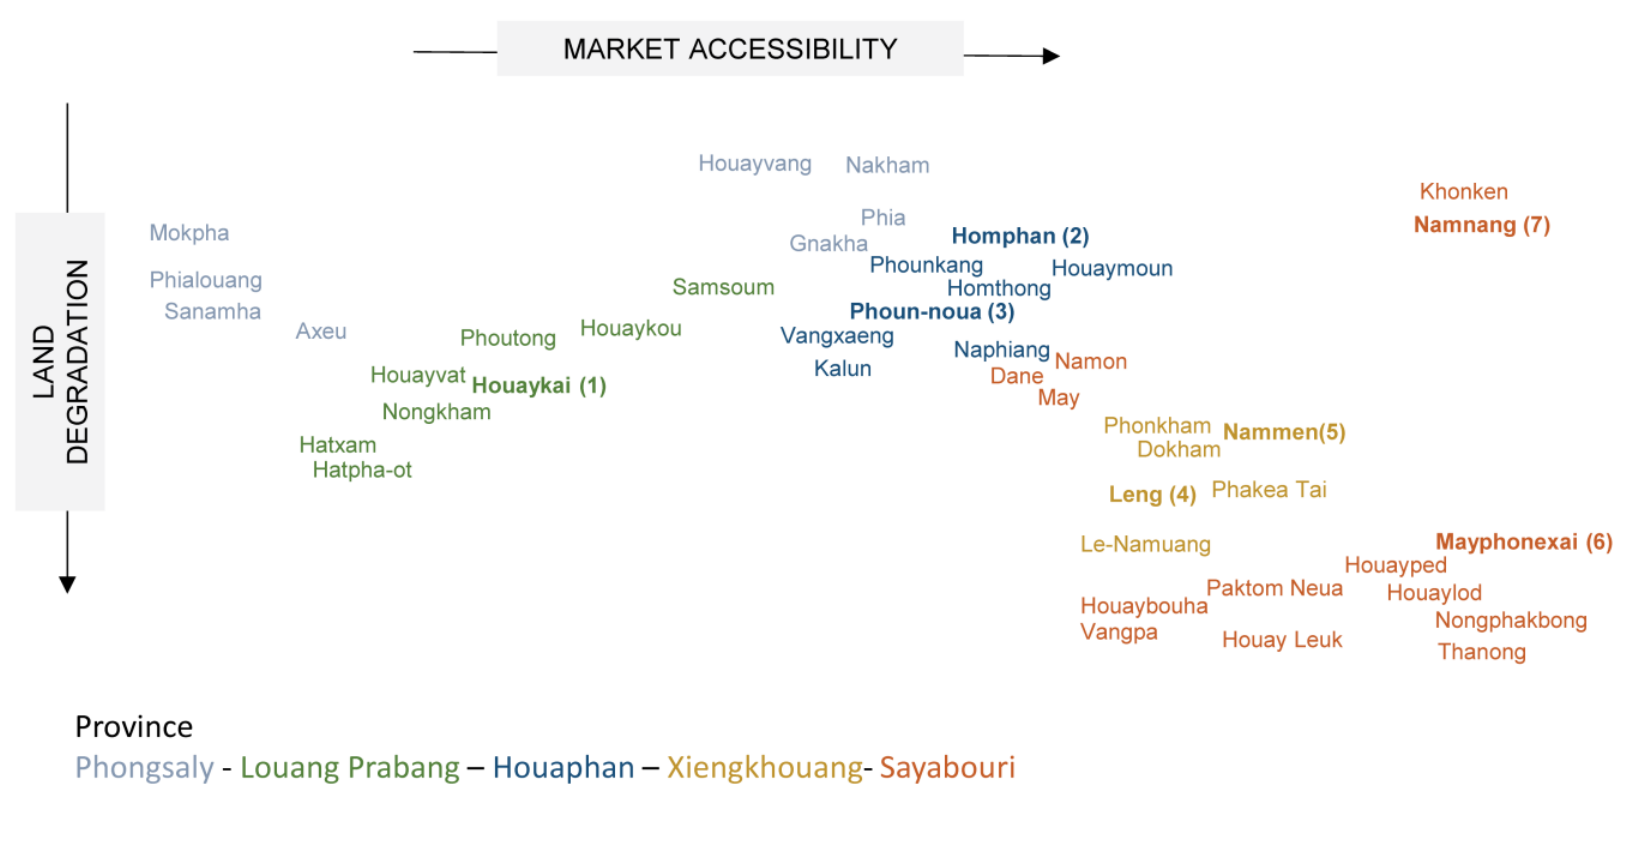
Figure A.1. EFICAS villages in respect to degree of market accessibility and land degradation mapped in a participatory workshop with experts. Bold villages were selected and surveyed chronologically according to the number in parentheses. Colors indicate respective province. Phongsaly Province was prone to an emerging maize boom as well, but had not yet engaged in hybrid maize cultivation at the time of our field work phase and was therefore not suitable to study the maize